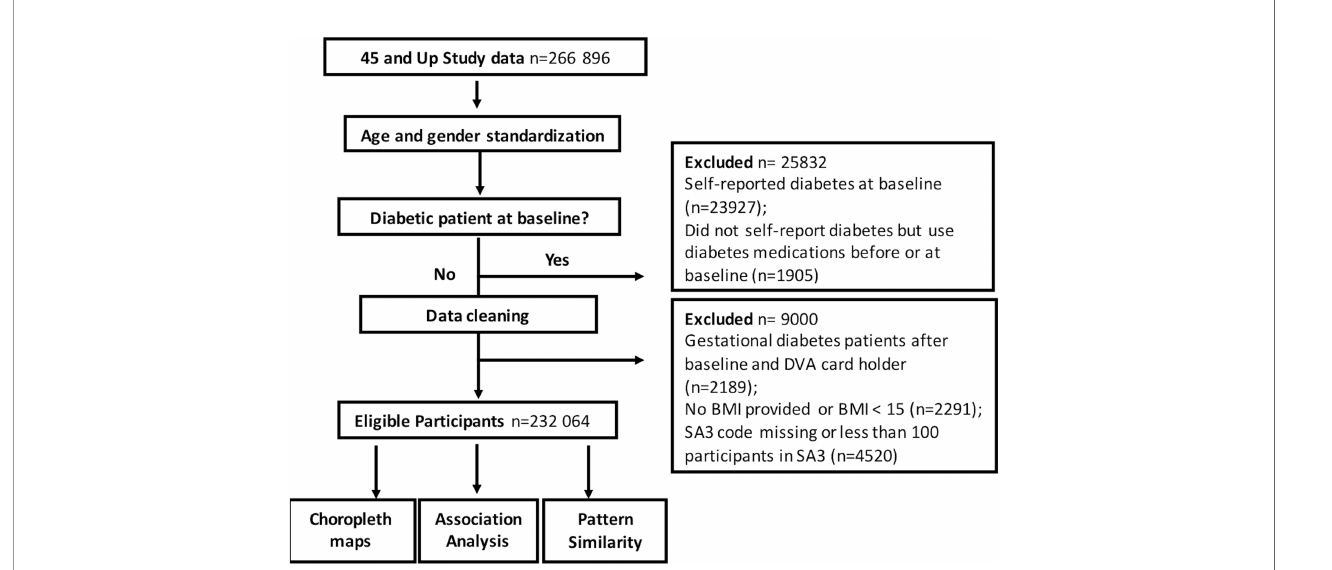
FIGURE 1 | Spatial Analysis of Diabetes Study Flow